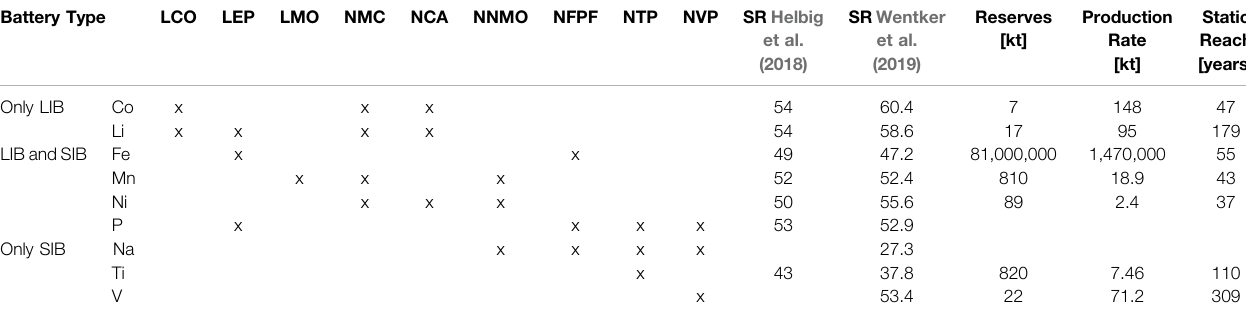
TABLE 5 | Supply risk and supply/demand situation of various battery materials. Battery